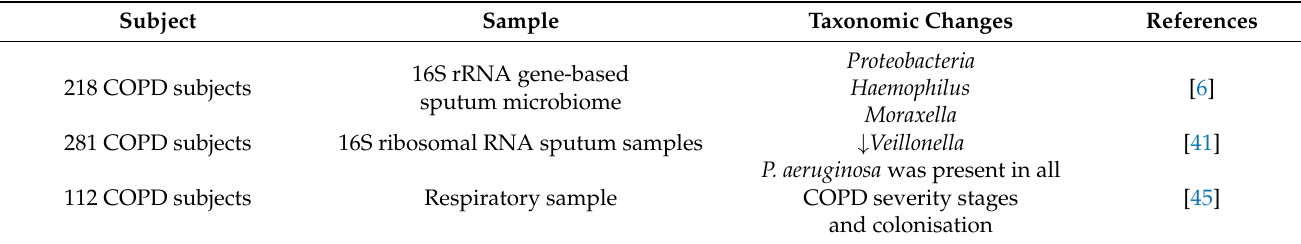
Table 1. Lung microbiota analysis in COPD